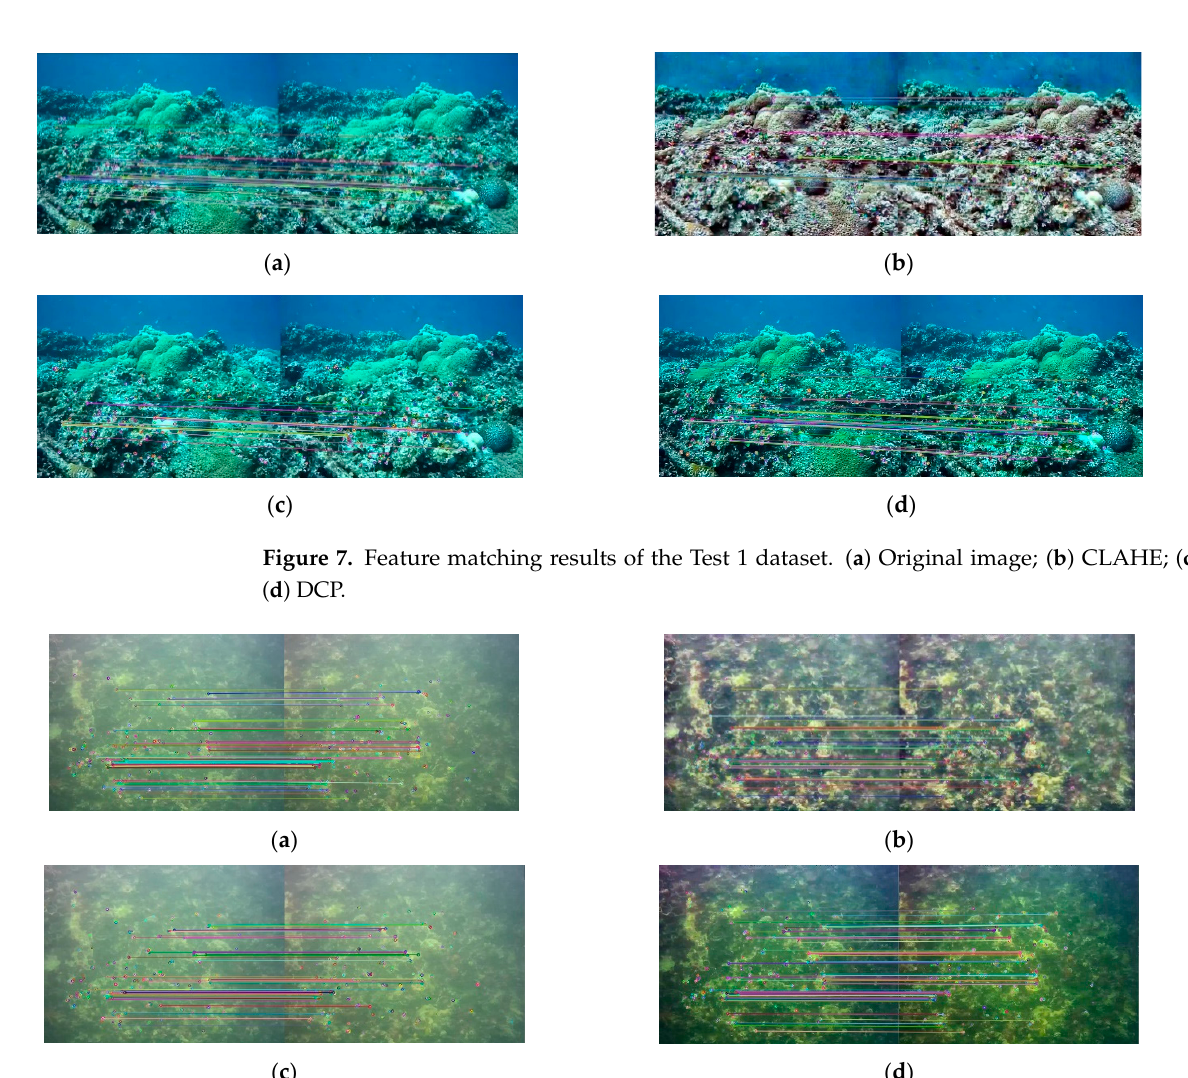
Figure 8. Feature matching results of the Test 2 dataset. ( a ) Original image; ( b ) CLAHE; ( c ) MF; ( d ) DCP.